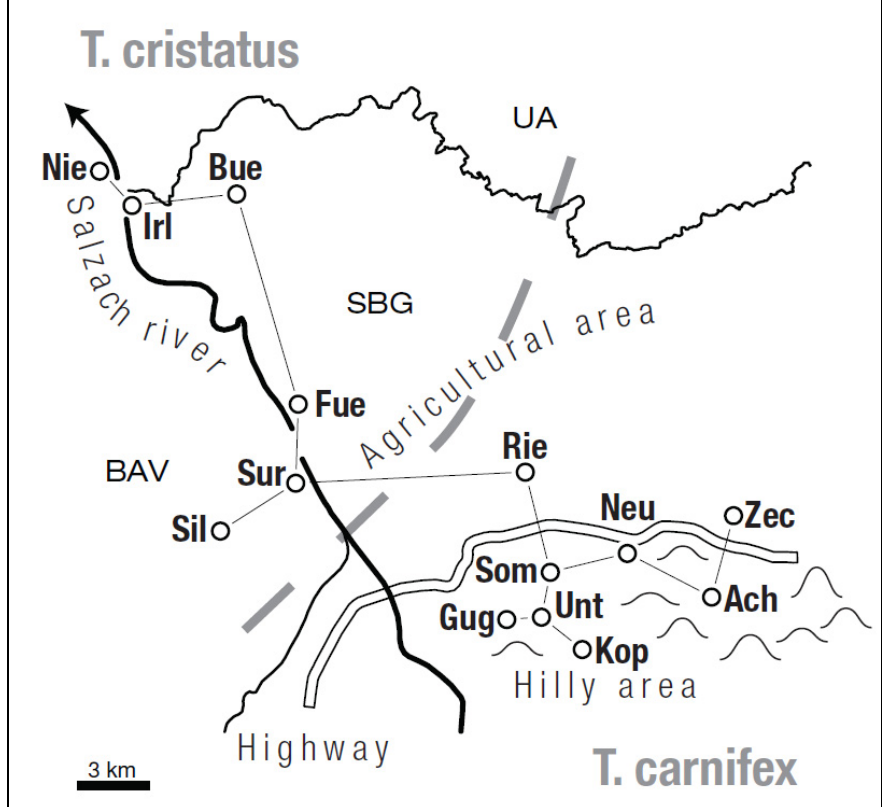
Figure 1. Study area with positions of sampled localities and a relative neighbour graph (RNG) showing distances between nearest neighbours; borders of Salzburg province (fine line); BAV = Bavaria, SBG = Salzburg, UA = Upper